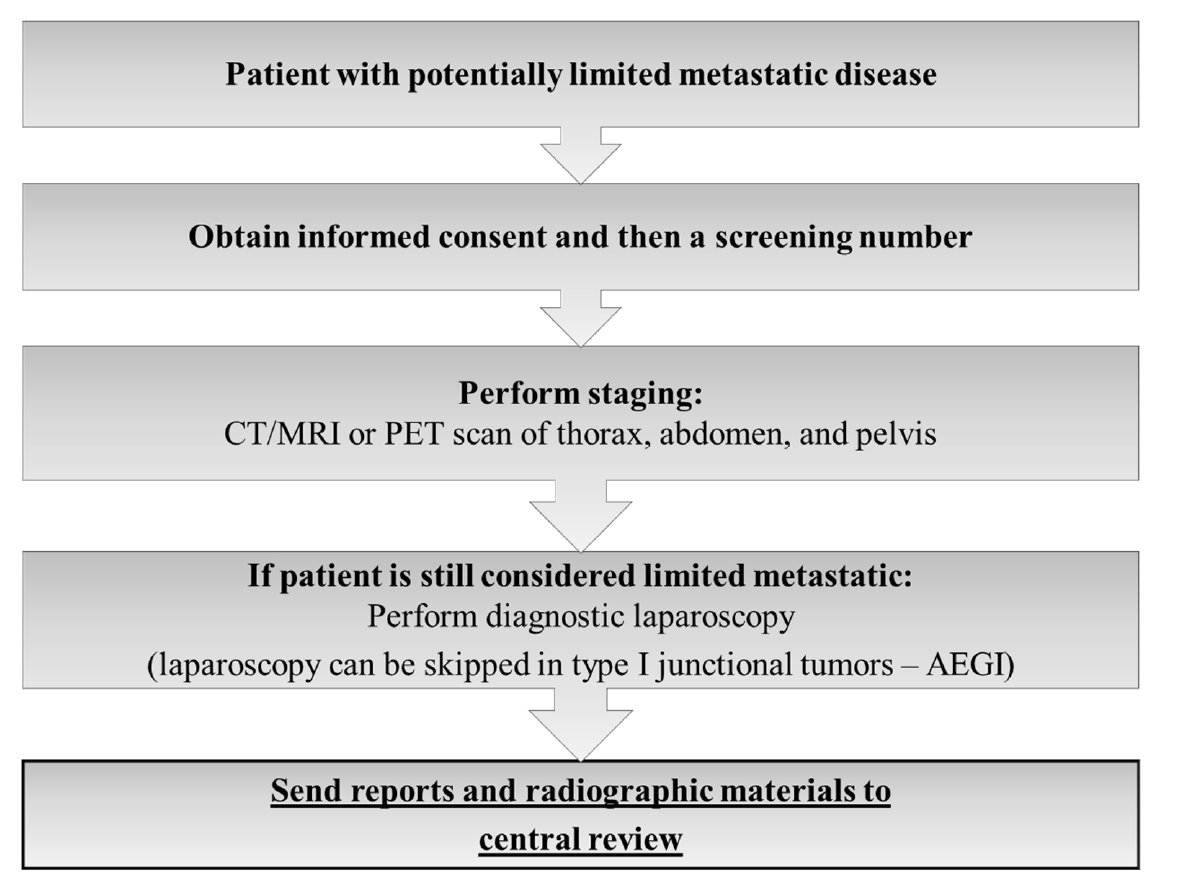
Figure 2. Information for decision ‐ making used by the FLOT ‐ 5 central review expert panel.